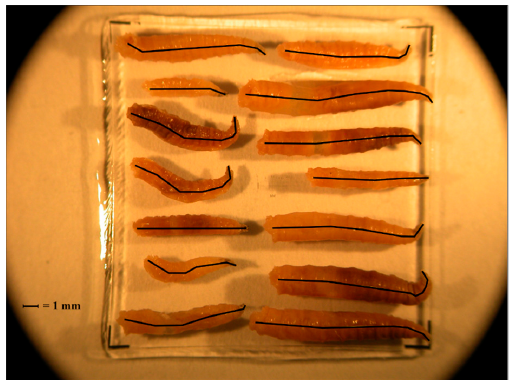
Figure 2. Example of third instars photographed on a micrometer slide and measured in ImageJ. Black lines indicate the midline that was measured in order to determine length of the larva.